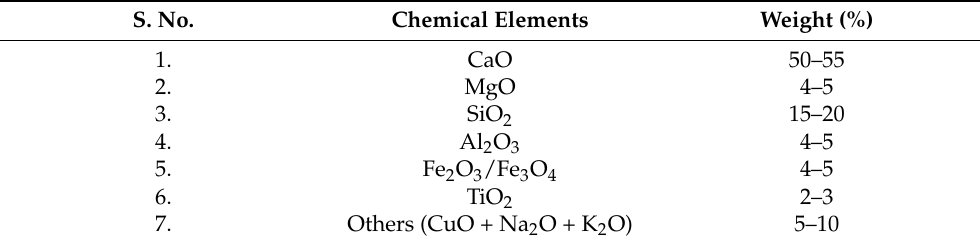
Table 3. The elemental composition of incense sticks ash by X-ray